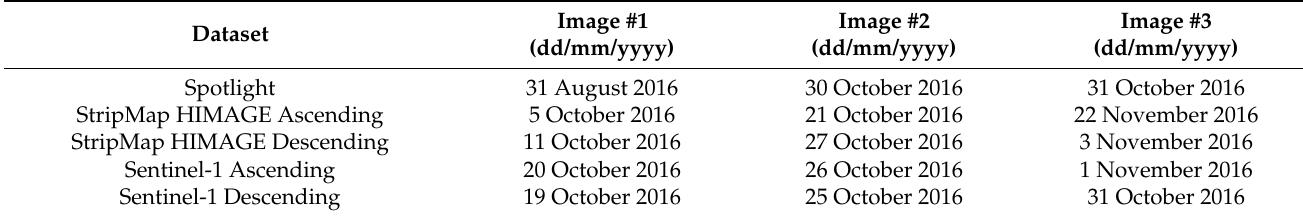
Table 2. RGB combination used for each stack for the ACD.